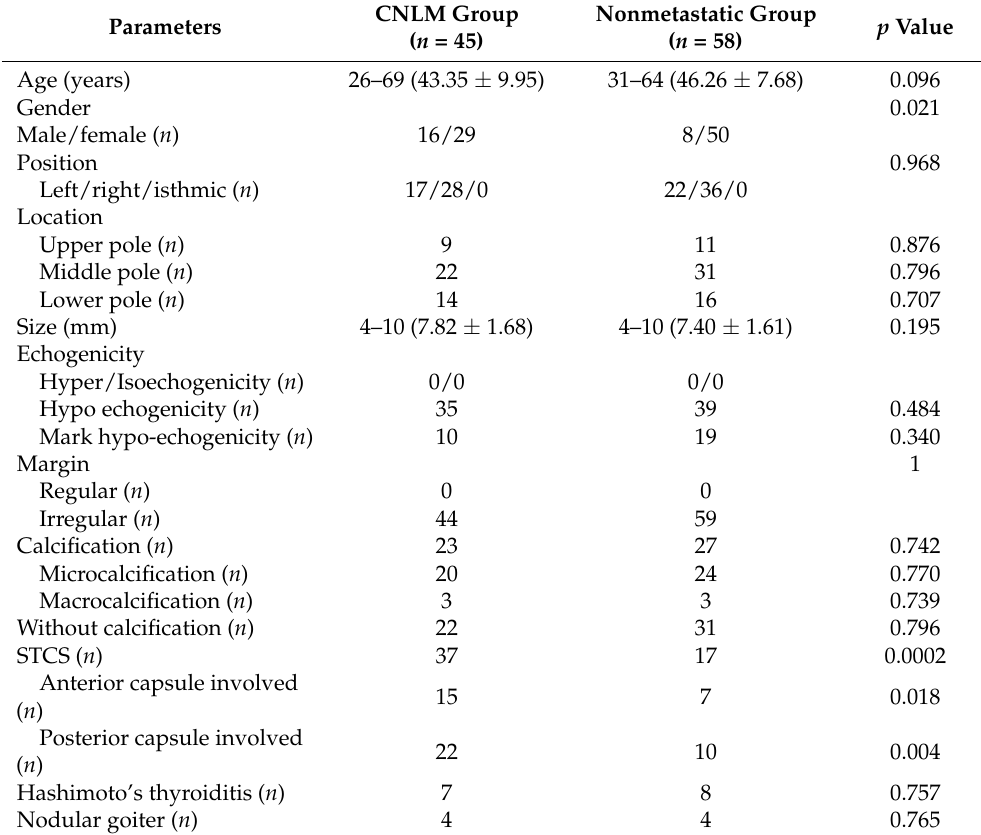
PTMC: papillary thyroid microcarcinoma; CNLM:central neck lymph node metastasis; STCS: sus- picious thyroid capsule involvement sign.